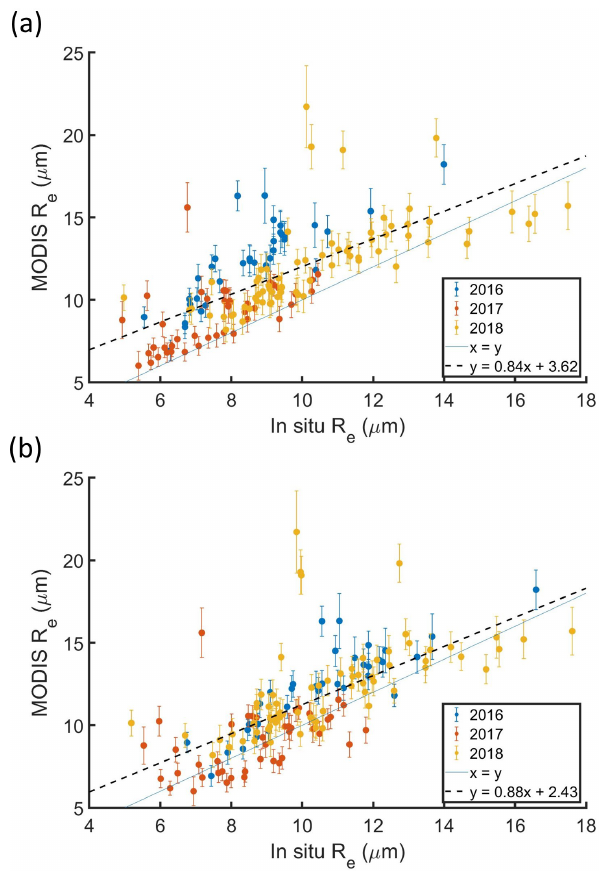
Figure A1. Same as Fig. 3a but with in situ R e calculated using (a) the unscaled CAS and CDP n ( D ) and (b) the CAS and CDP n ( D ) scaled based on the King